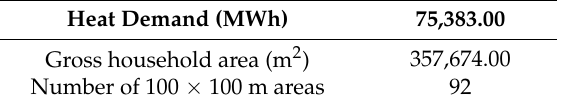
Table 2. Main results of the district heating implementation feasibility